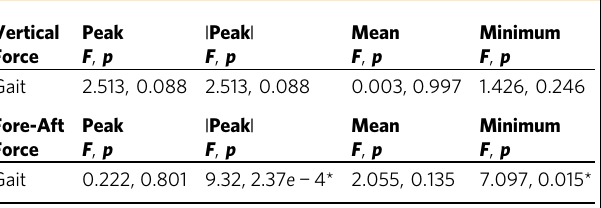
Table 1 ANOVA table showing F -statistic and p -value for gait as a predictor of locomotor forces